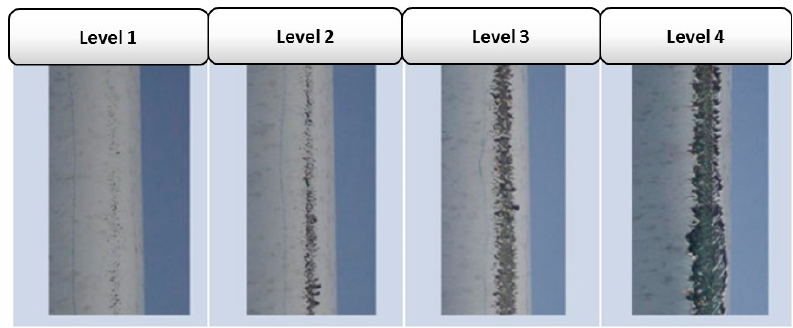
Figure 3. Leading edge erosion [43].